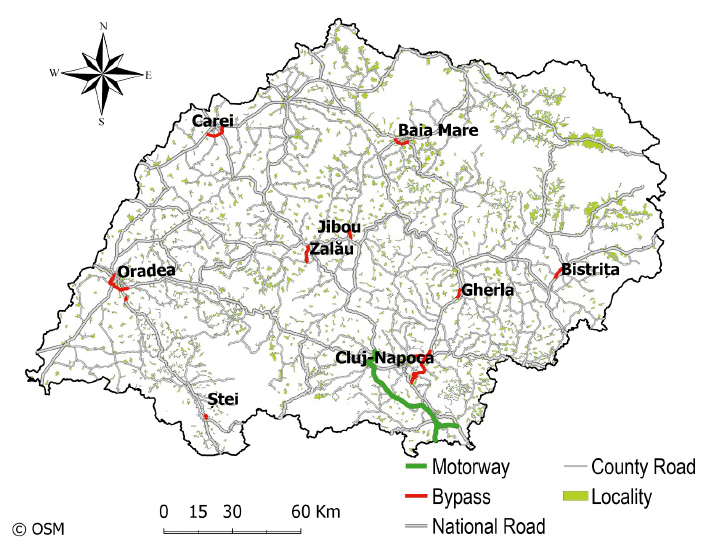
Figure 2. The motorways and bypasses in the N-W Region of Romania, 2019